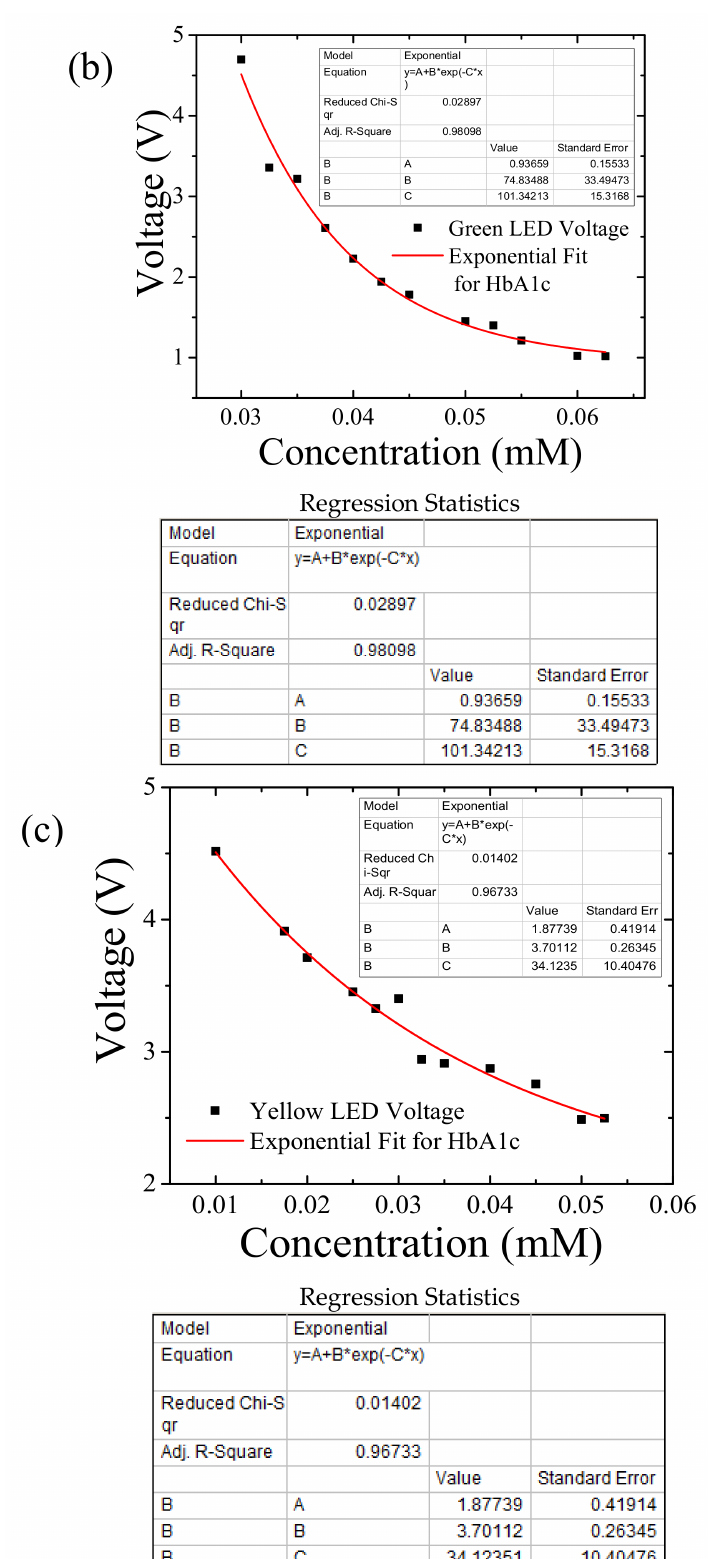
Figure 4. ( a ) The absorption spectra of diluted concentrations of glycohemoglobin A1c solutions measured at room-temperature. ( b ) Photodiode output voltage (averaged over 500 voltage readings) as a function of concentration for diluted concentrations of glycated hemoglobin using green LED and ( c ) yellow LED. The data points are fitted to an exponentially decaying equation using a three-variable regression